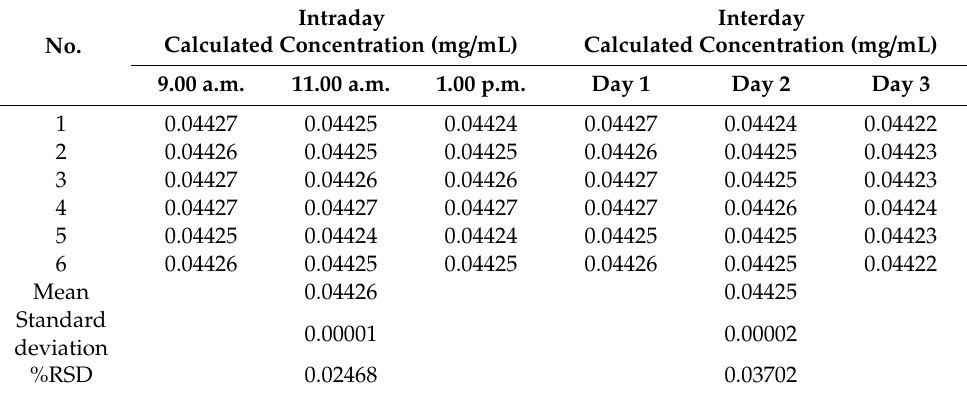
Table 3. Precision tests of the scopoletin amount using